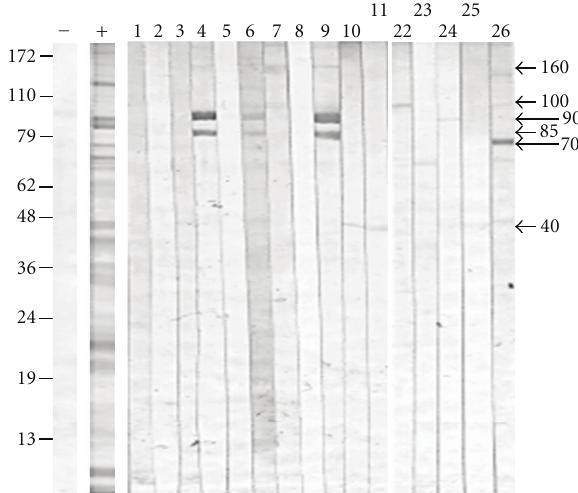
Figure 3: Western blot with Taenia solium tapeworm CE was tested with hamster sera infected with T. solium tapeworms (1– 33). Preimmune (lane − ) and hyperimmune hamster sera against T. solium tapeworm CE (lane +) were used as negative and positive controls. WB shows representative samples of the assay. Number of lanes is corresponding to serum number of the assay.